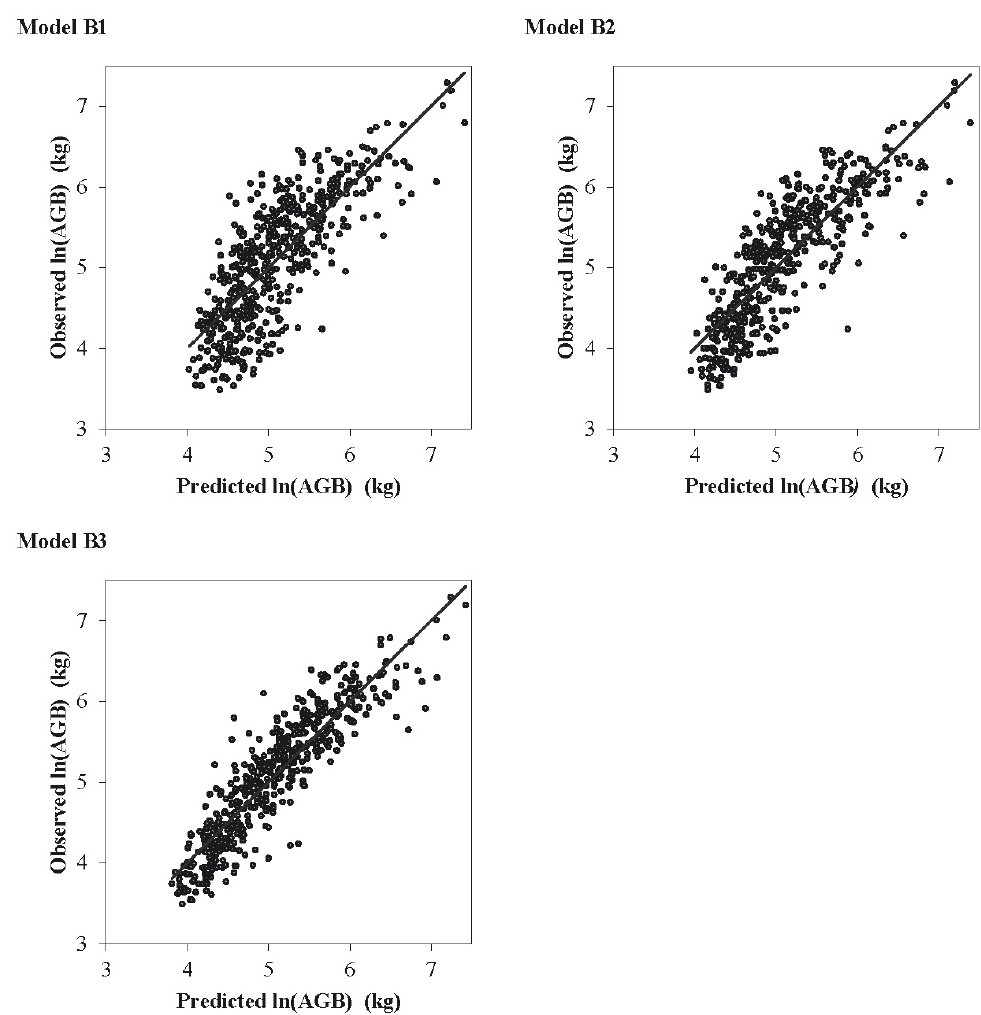
Figure 4. Predicted vs. observed aboveground biomass (AGB) for three selected black pine aboveground biomass models. The solid line represents fitted linear model. Models’ description and evaluation statistic are presented in Table